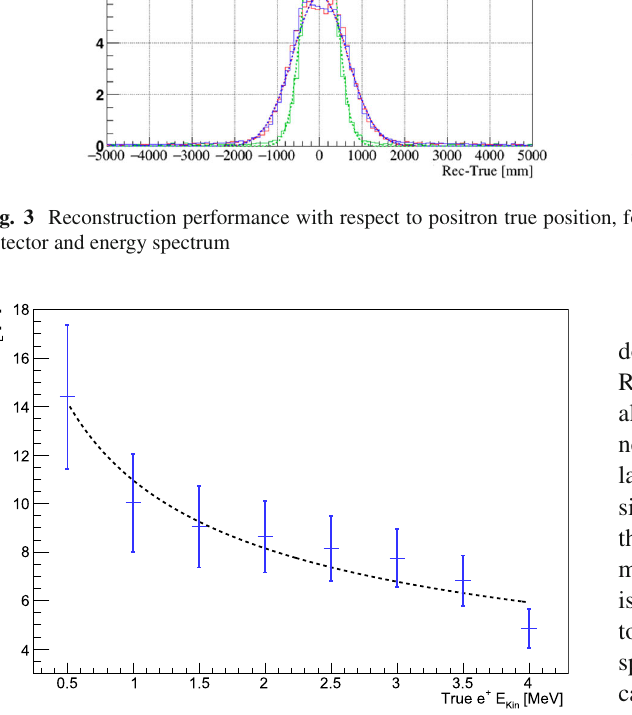
Fig. 4 Energy resolution for positrons generated at the center of the detector volume between 0 . 5MeV to